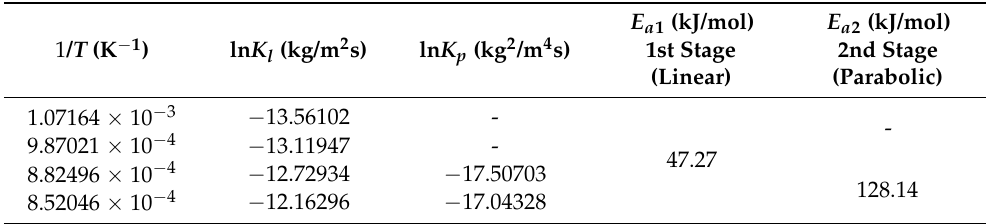
Figure 9. ln of the linear ( 𝐾 𝑙 ) and parabolic ( 𝐾 𝑝 ) oxidation rate constants as a function of the inverse exposure time ( 𝐾 − 1 ) to obtain the activation energy ( 𝐸 𝑎 ) for the two different oxidation stages. Table 2. Data used to determine the apparent activation energy for the two oxidation stages of the Ni-based alloy under study.